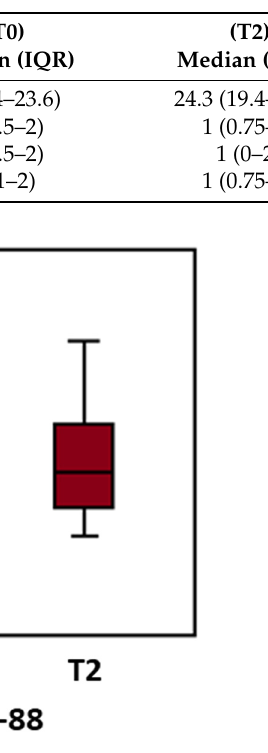
Table 2. Median and IQR of clinical scale at baseline (T0) and post-treatment (T2). GMFM 88, Gross Motor Function Measure-88 total values; MAS H, Modified Ashworth Scale for hip muscles; MAS K, Modified Ashworth Scale for knee muscles; MAS A, Modified Ashworth Scale for ankle muscles.